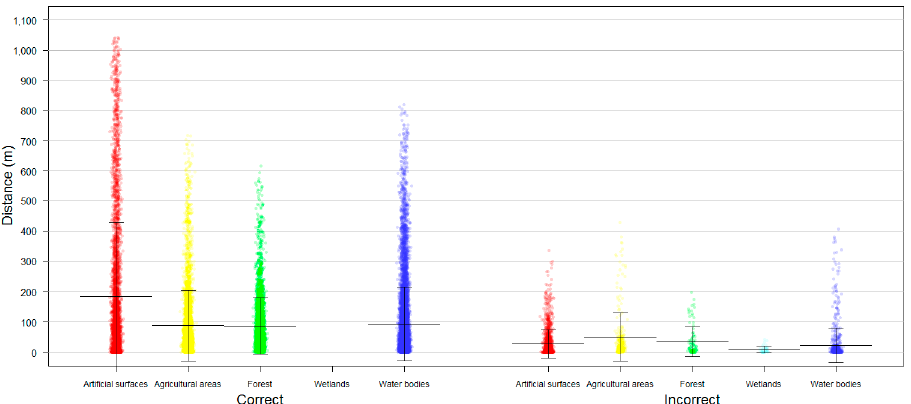
Figure 5. Correct and incorrect training samples of each LULC class according to their distance from feature boundary.